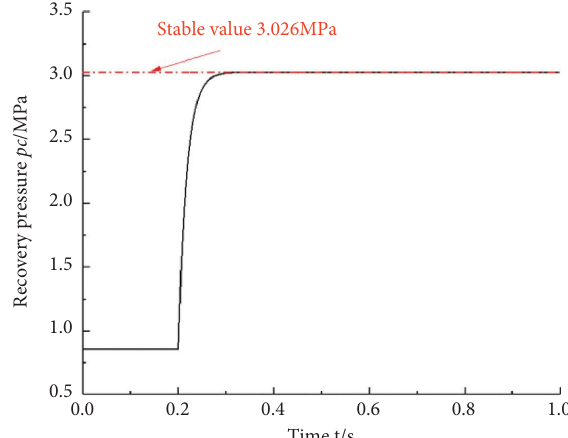
Figure 8: Simulation curve of the front stage under fxed return oil